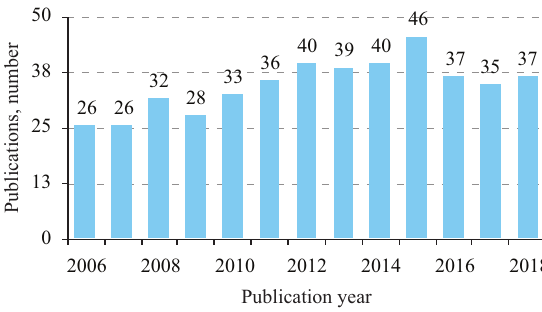
Figure 2. Distribution of the Baltic Journal of Road and Bridge Engineering